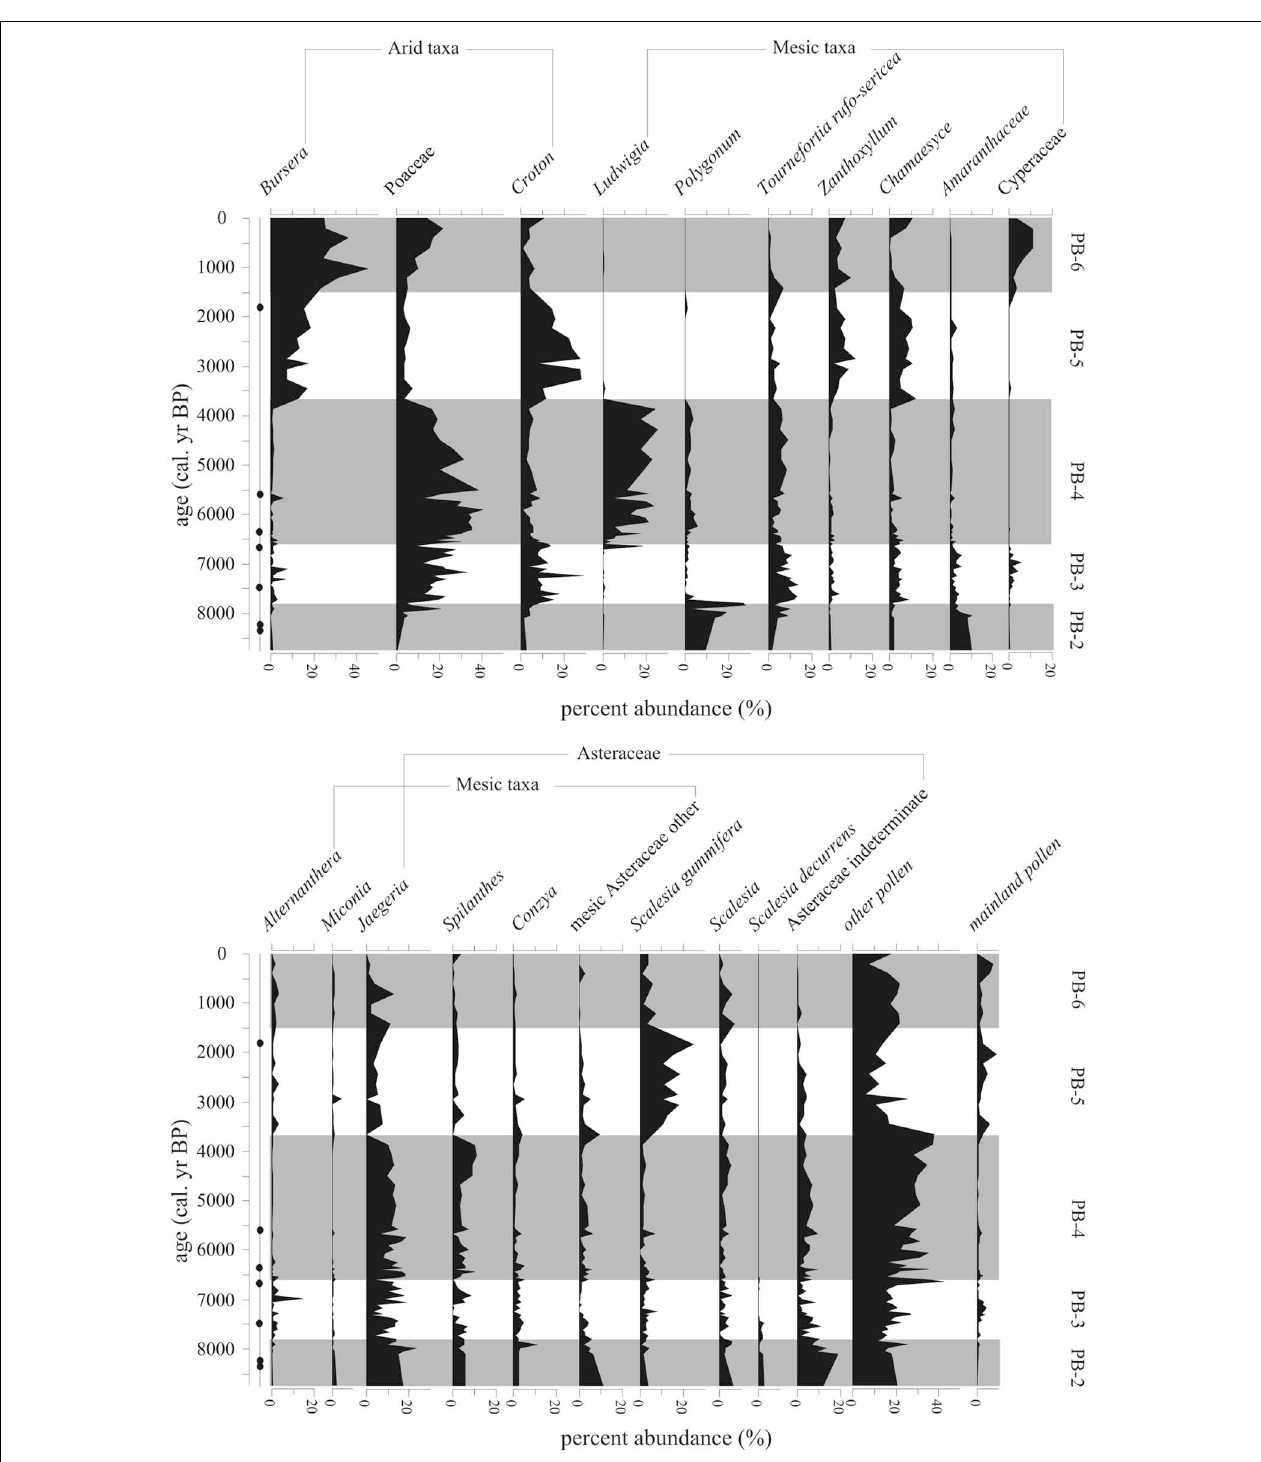
FIGURE 7 | Percent abundance (%) of 20 most common taxa ( > 5%) within the Holocene-aged samples (8740-0 cal. year BP) from Paul’s Bog. Local pollen zones are shown. Radiocarbon date locations (solid circles) on right of age axis.